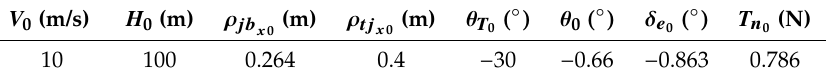
Table 10. Aircraft Model 2 trim condition before pull up.